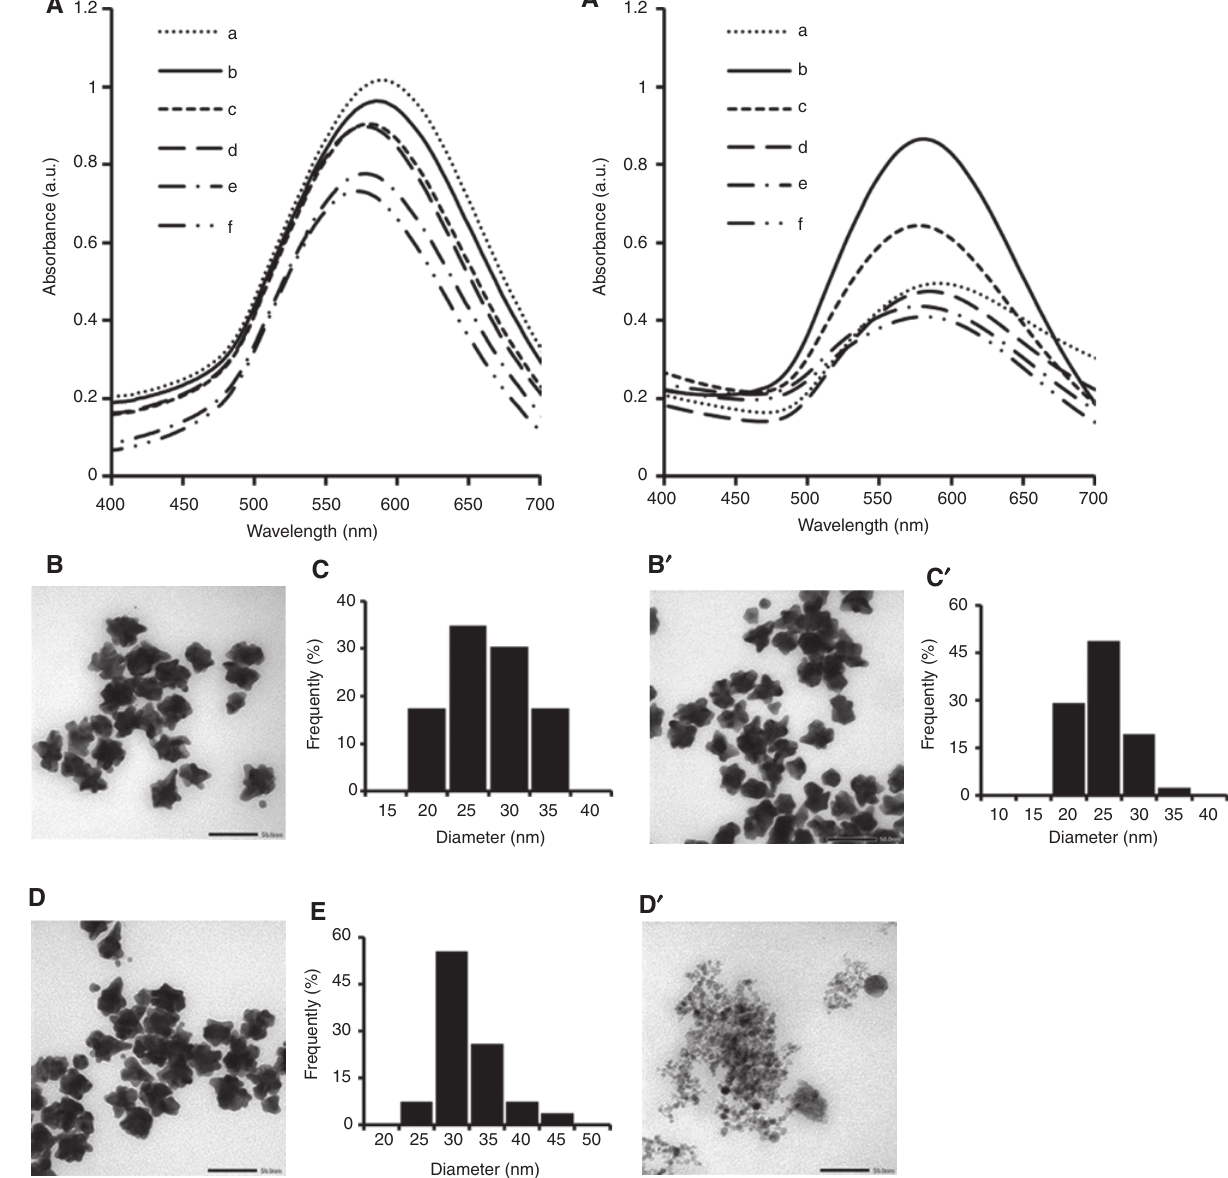
Figure 3: UV-Vis absorption spectrum of samples a to f (A) and after 1 month (A ′ ) and TEM image (scale bar, 50 nm) and size distribution of sample b (B and C) and sample f (D and E) and after 1 month b (B ′ and C ′ ) and f (D ′ ), respectively.